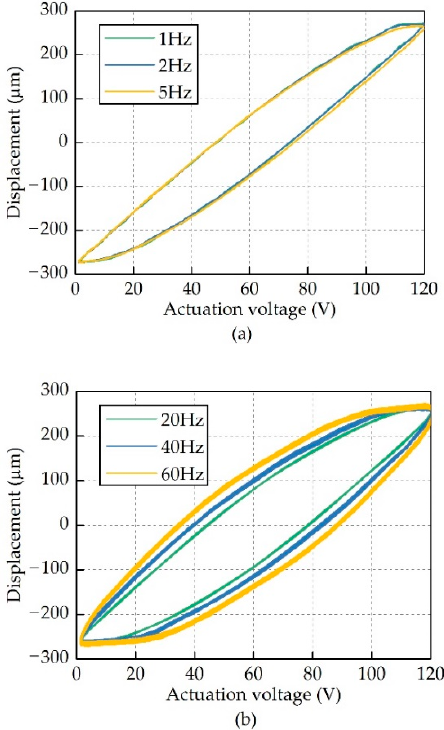
Figure 3. Hysteresis curves at different frequencies. ( a ) Hysteresis curves at low frequencies ( b ) Hysteresis curves at high actuation frequencies.